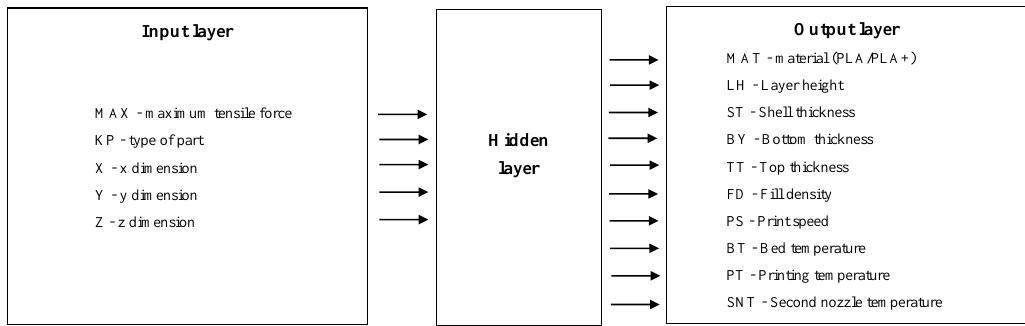
Figure 2. Artificial neural network (ANN) structure: Inputs and outputs.